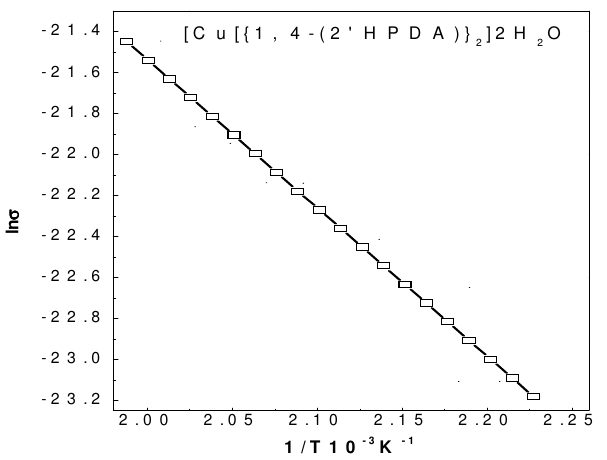
Figure 2. Temperature dependence of electrical conductivity